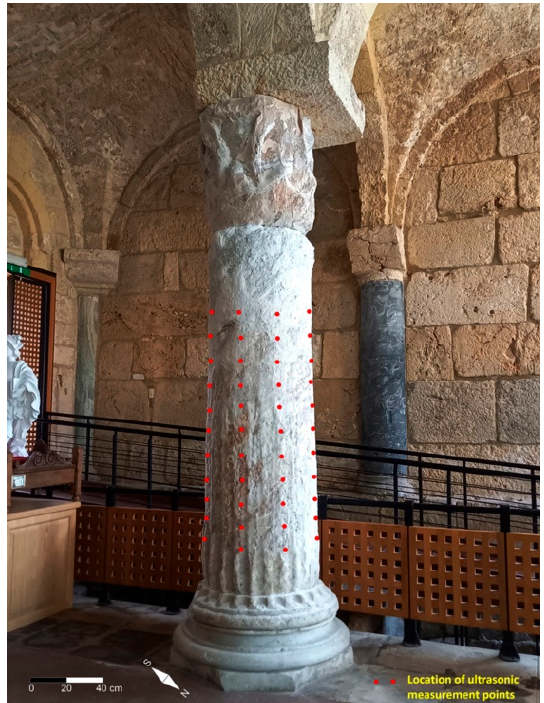
Figure 6. Location of the ultrasonic measurement points on the studied